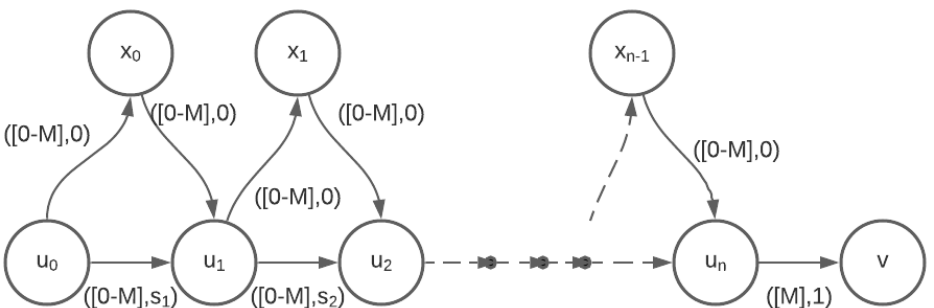
Figure 6. Interval-temporal graph for NP-hard